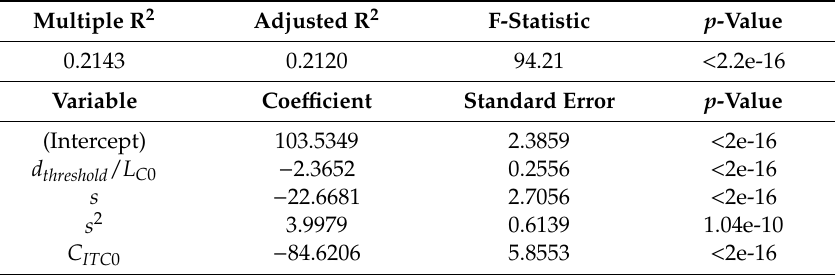
Table 4. Regression analysis of maximum non-orthogonality.